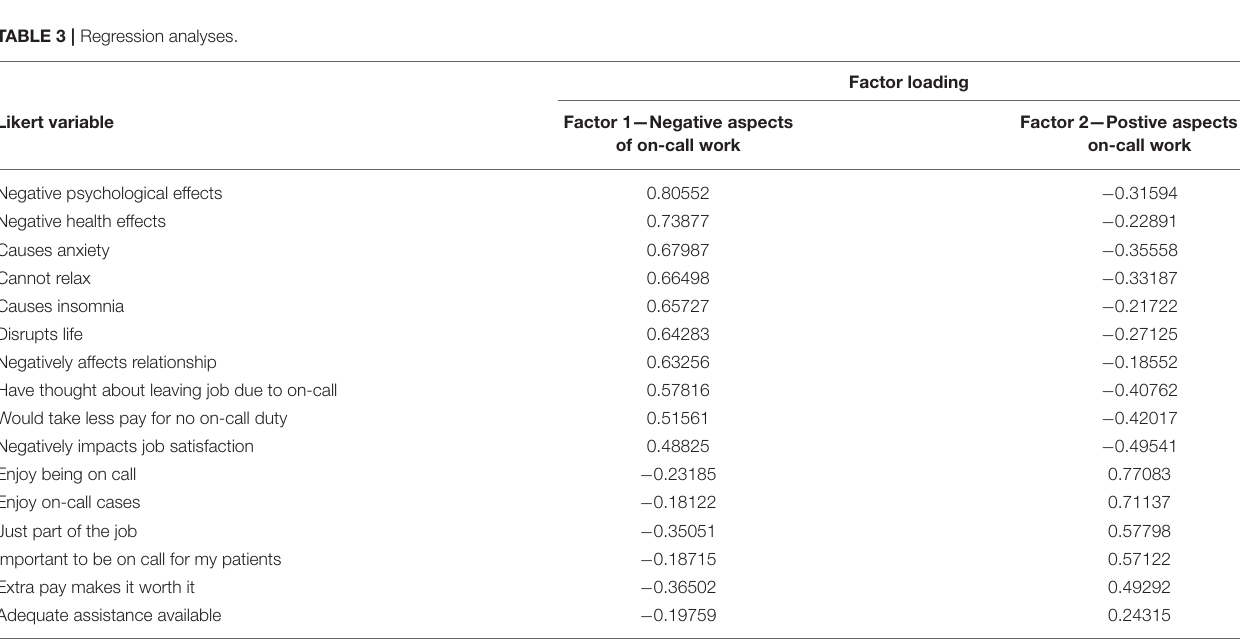
TABLE 3 | Regression